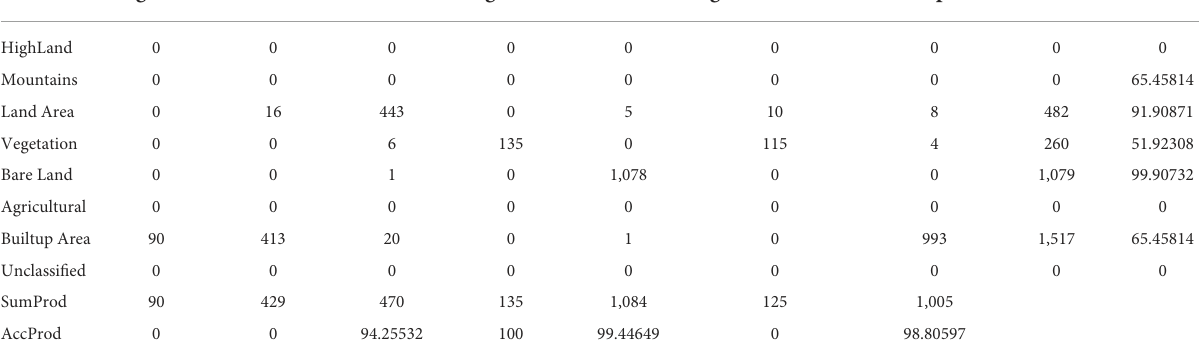
TABLE 9 Confusion matrix for (ANN_RF) proposed work method of Landsat-8 satellite